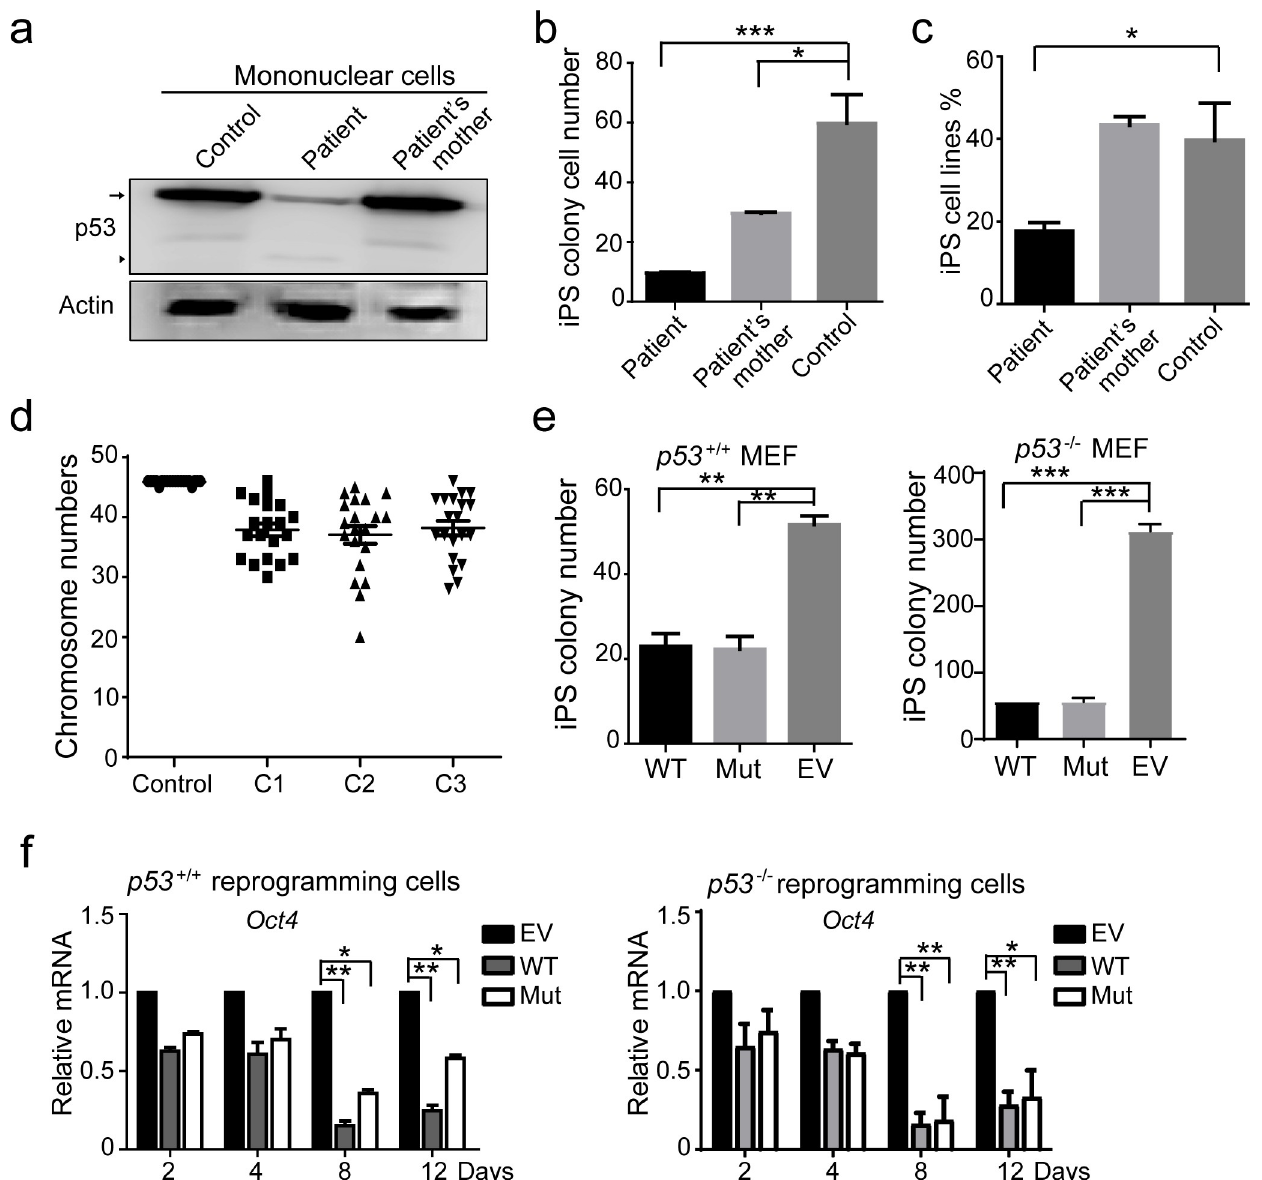
Fig 3. The p53 p.Asn268Glufs � 4 mutation inhibits iPS cell generation. a. WB of p53 protein levels. Mononuclear cells in healthy people with the same age as the patient were used as a control. Arrow, WT p53; arrow head, p53 mutant. b. iPS colony numbers per 1 × 10 6 monocyte cells used to generate iPSCs at Day 14 after transduction. ��� , p < 0.001. c. The percentage of iPS cell lines established on Day 16 after transduction. �� , p < 0.01. d. Chromosome numbers in three patient iPS cell lines. e. iPS colony numbers following introduction of WT p53, mutant p53 and vector into p53 +/+ and p53 -/- MEFs were counted on reprogramming Day 14 after transduction. f. Real-time PCR (RT-PCR) of expression of OCT4 in cells following introduction of WT p53 and mutant p53 compared with vector control at the indicated reprogramming time points. fibroblast (MEF) cells and then MEFs were reprogrammed to iPS cells. The numbers of iPS colonies in the mutant and WT groups on the 14th day of reprogramming were significantly lower than that in the control group (Fig 3E). However, p53 R175H did not affect the repro- gramming rate (S1F Fig). Compared the expression of pluripotent genes on Day 2 nd , 4 th , 8 th , and 12 th during reprogramming, Oct4 expression in p53 WT and mutant cells had been